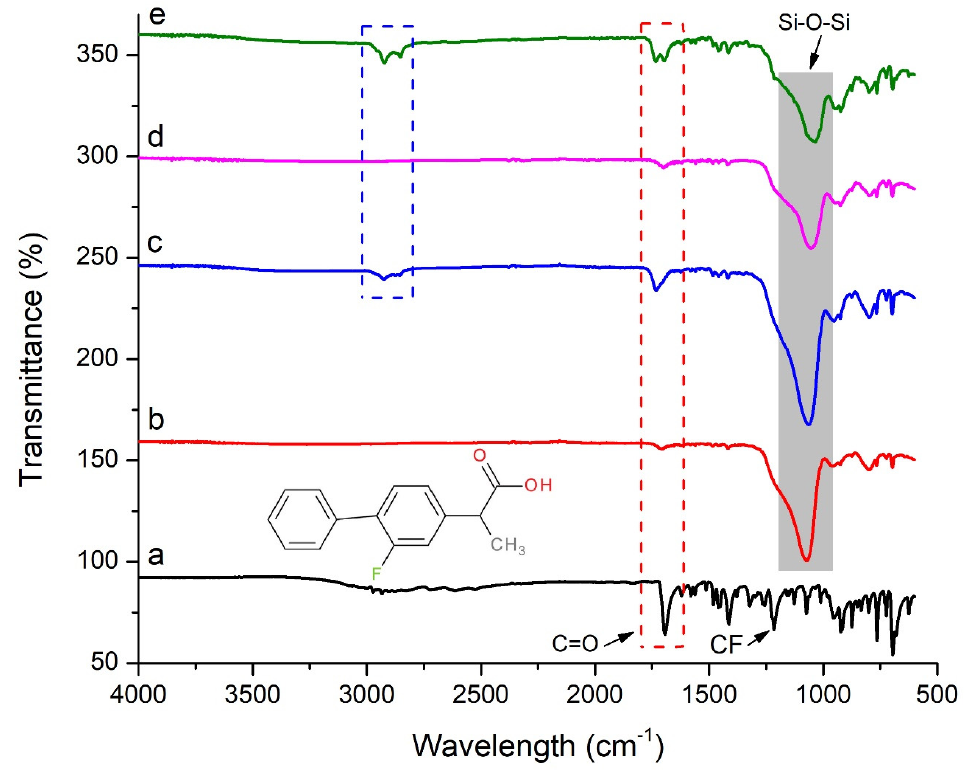
Figure 2. FTIR spectrum of ( a ) flurbiprofen, ( b ) S1, ( c ) S6, ( d ) S7, and ( e ) S12.